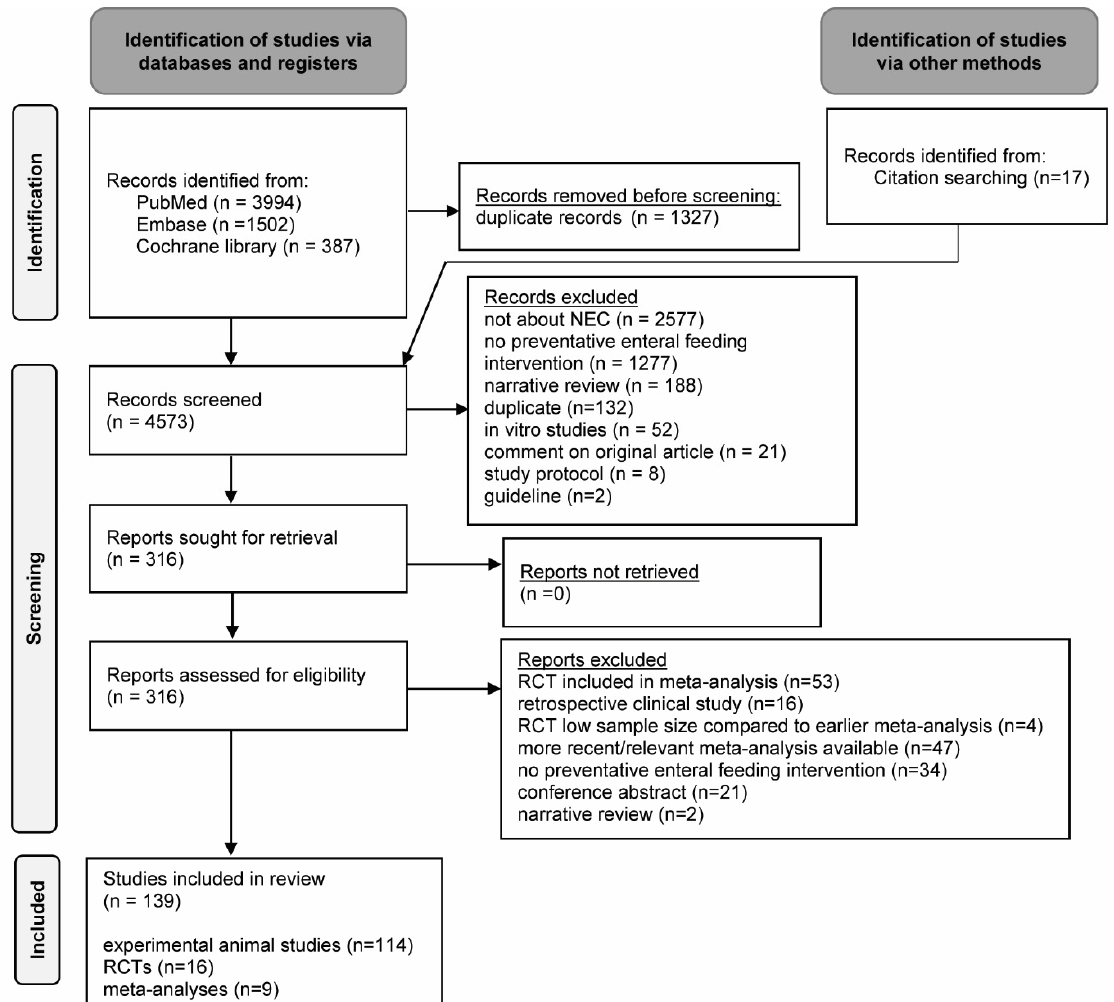
Figure 2. Flowchart of the article selection. Adapted from the PRISMA 2020 statement. Page, M.J.; McKenzie, J.E.; Bossuyt, P.M.; Boutron, I.; Hoffmann, T.C.; Mulrow, C.D.; Shamseer, L.; Tetzlaff, J.M.; Akl, E.A.; Brennan, S.E.; et al. The PRISMA